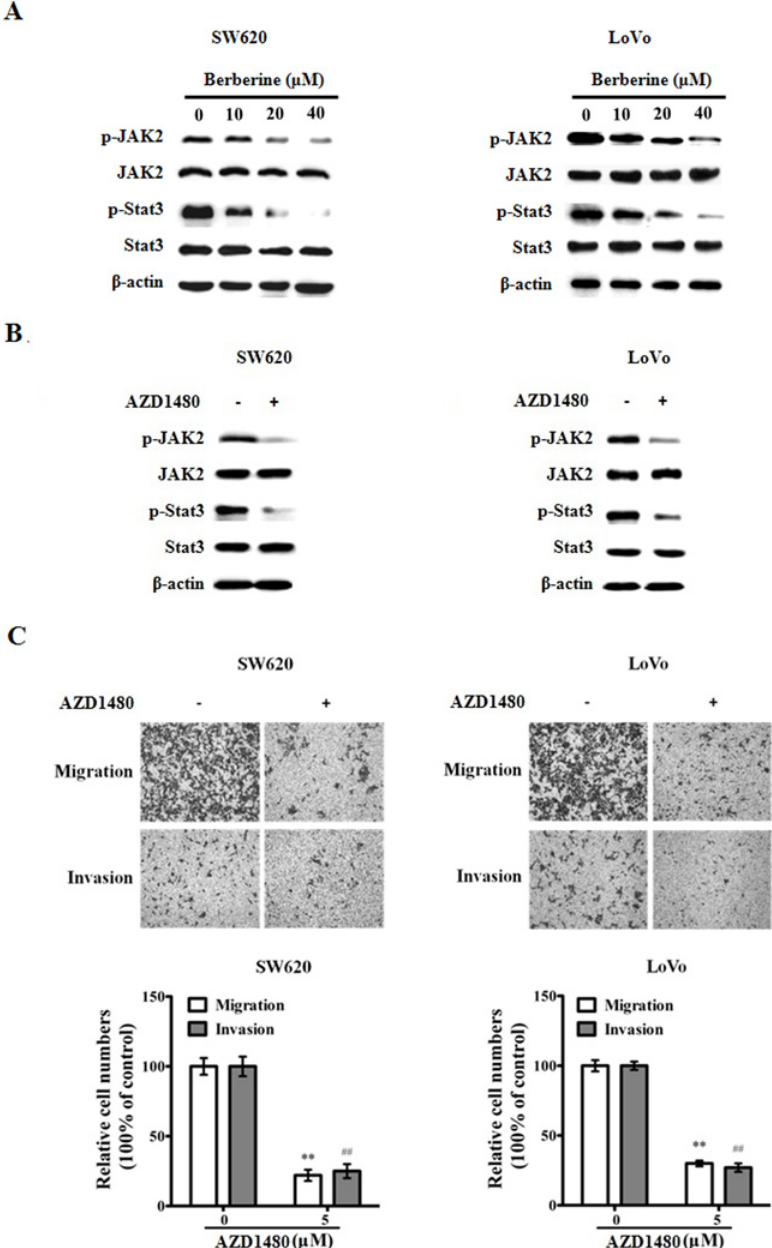
Fig 3. Berberin blocks JAK2/STAT3 signaling in CRC cells. A. Extracts from SW620 and LoVo cells treated with berberin at indicated concentrations for 48 h were analyzed for pJAK2, JAK2, pSTAT3, STAT3 and beta-actin (as loading control). B. JAK inhibitor AZD1480 blocks JAK2/STAT3 signaling. Extracts from SW620 and LoVo cells treated with AZD1480 (5 μ M) were analyzed for the expression of pJAK2, JAK2, pSTAT3, STAT3 and beta-actin. C. AZD1480 inhibits migration and invasion of CRC cells. The results shown are representative of three independent experiments. The bars and error bars represent the means ± SE, and the P -value was calculated using an independent t -test. ** P < 0.01, migration control vs treated; ## P < 0.01, invasion control vs